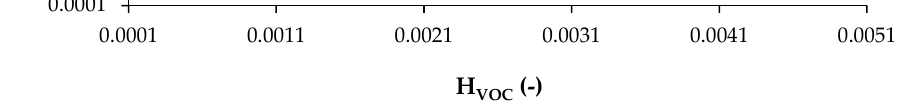
Figure 7. K L a versus Henry coefficient (from the data analysis reported in Reference [6]). Diamond: gas flow-rate = 1.0 × 10 −5 m 3 /s; circle: gas flow-rate = 1.25 × 10 −5 m 3 /s; square: gas flow-rate = 1.50 × 10 −5 m 3 /s. Table 4. K L a determination using the data reported in Bourgois et al. [6]. For all the experiments, solvent: DEHP (di-2-ethylhexyl phtalate); gas flow-rate = 1.39 × 10 −2 m 3 /s (gas EBRT = 1 s; V = 1.46 × 10 −2 m 3 ).